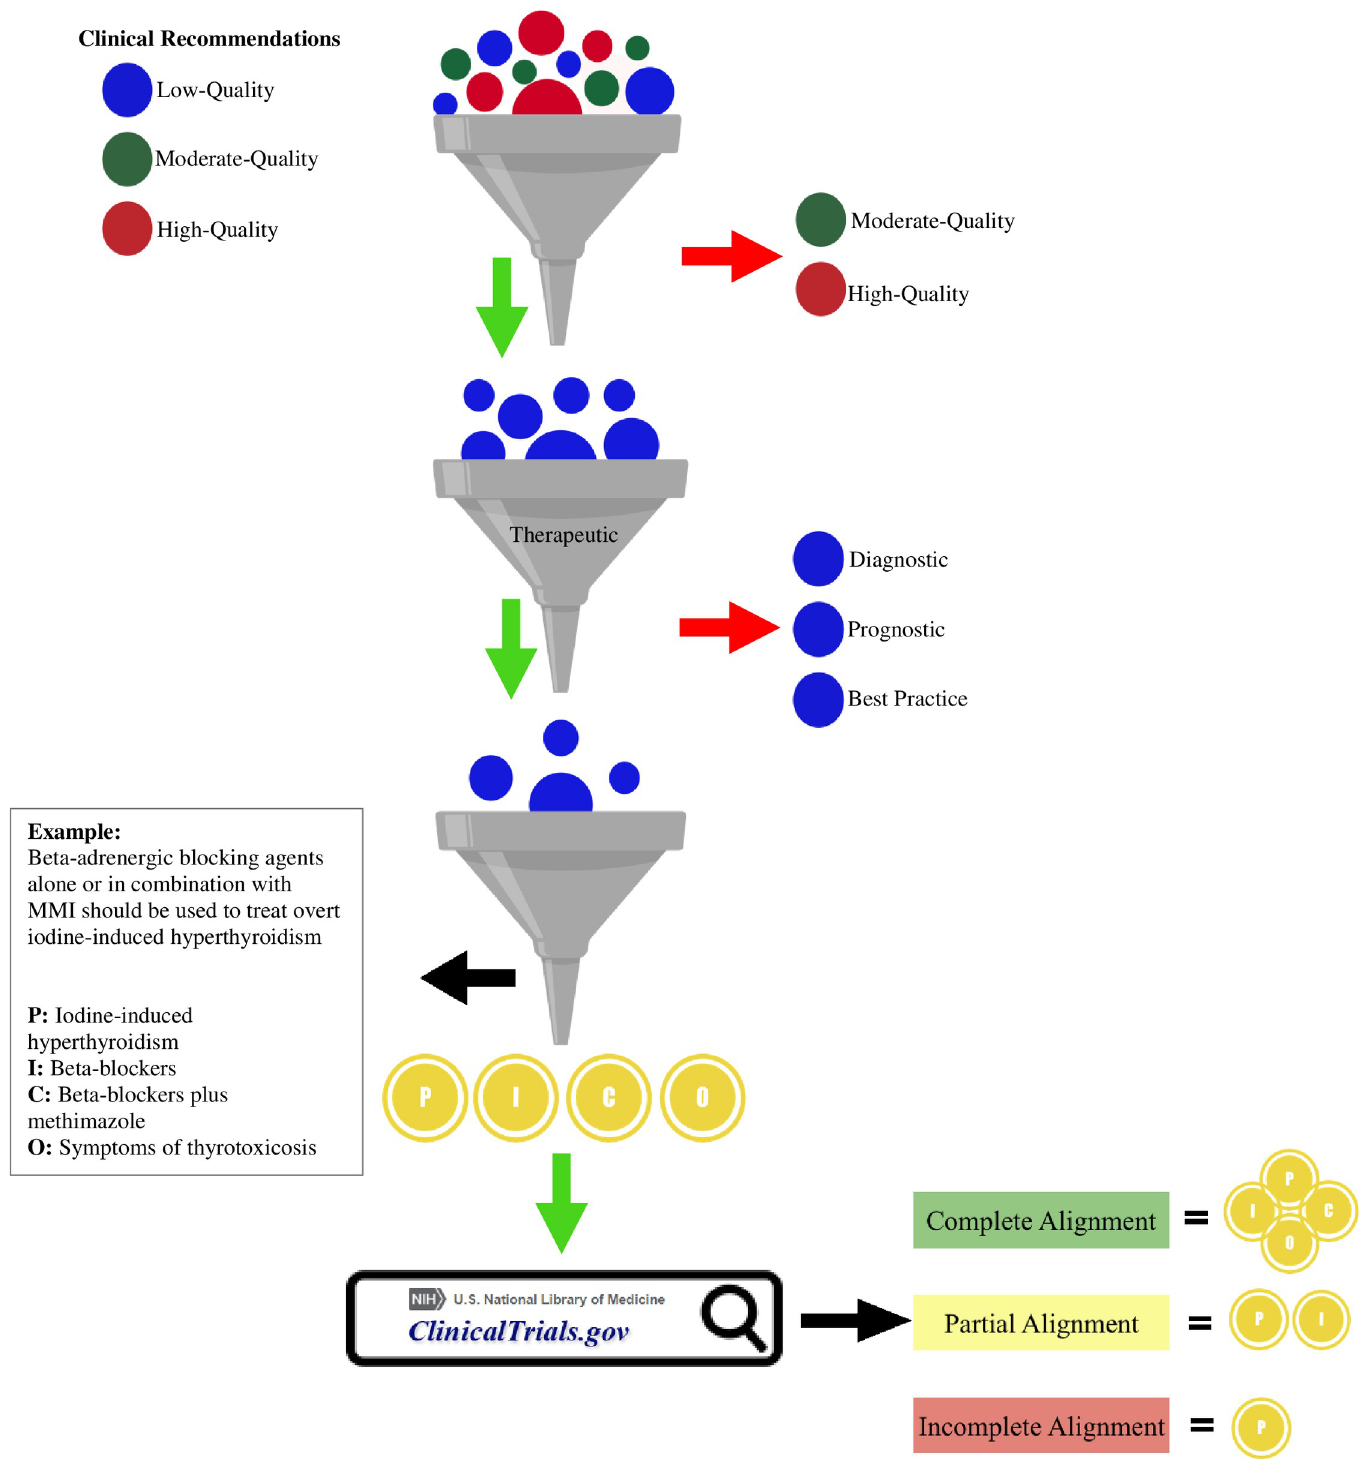
Fig 1. Summary of methods. Balls represent clinical recommendations. Red arrows mean exclusion criteria, whereas green arrows means inclusion criteria. P: Patient; I: Intervention; C: Comparison; O: Outcome.